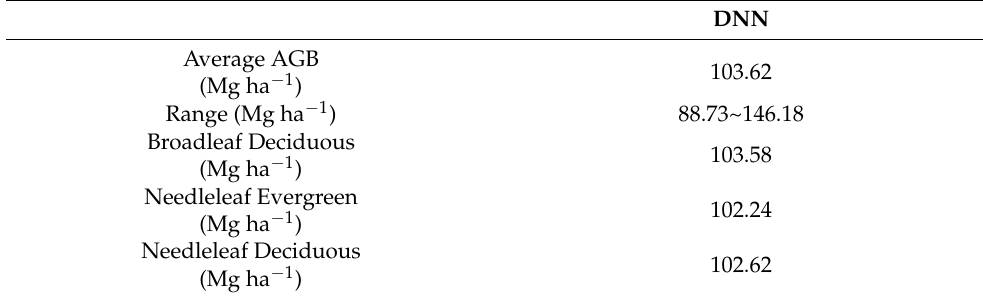
Table 4. Average AGB values of different models at different distances from